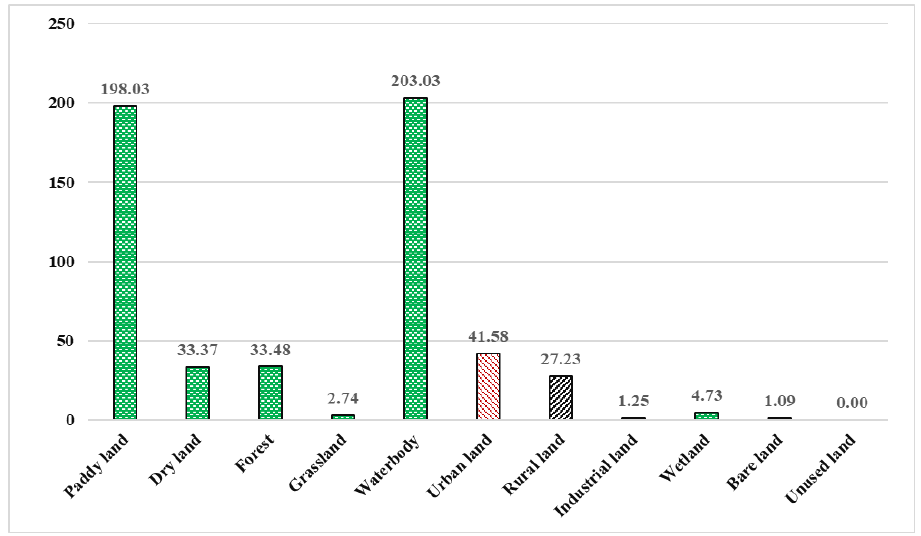
Figure 5. Landscape composition and area of encroachments within corridors buffer of GENs (km 2 ).